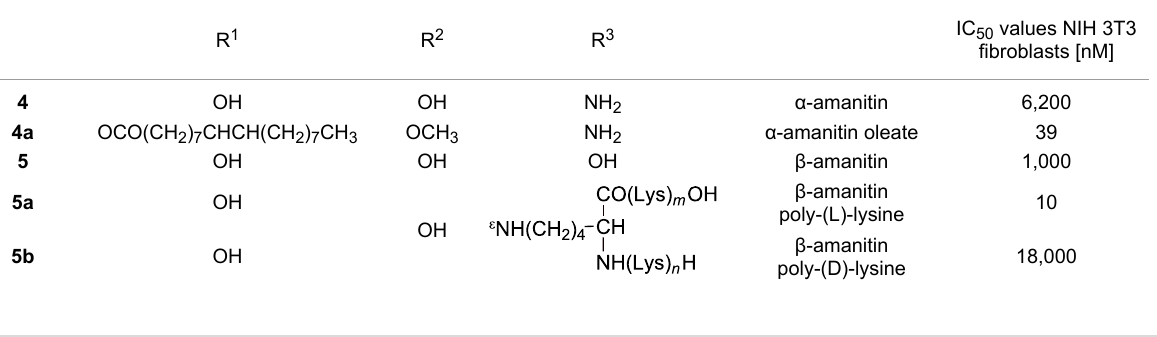
Table 2: Structures of amanitin derivatives and IC 50 concentrations of growth inhibition in mouse fibroblasts after 72 h incubation time (MTT cell prolif- eration assay).